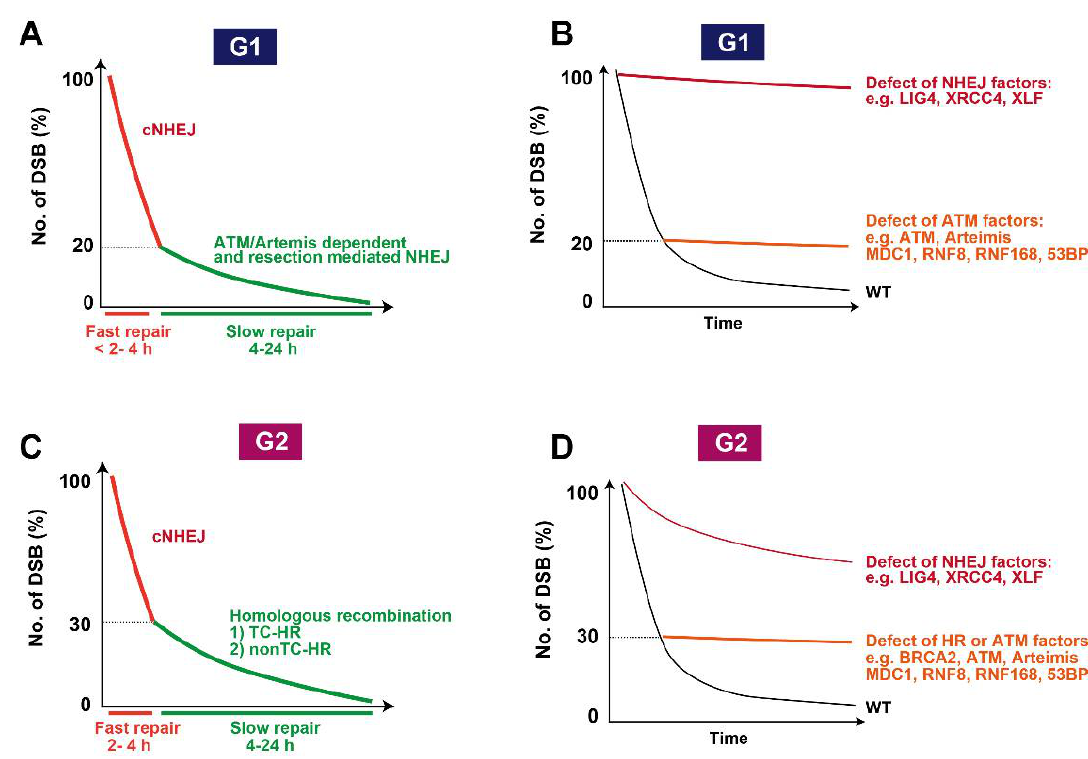
Figure 3. DSB repair kinetics after <1–5 Gy. ( A ) DSB repair kinetics in G1 phase. ( B ) An example of repair kinetics in defective NHEJ or ATM-related factors is shown. ( C ) DSB repair kinetics in G2 phase. ( D ) An example of repair kinetics in defective NHEJ, HR, or ATM-related factors is